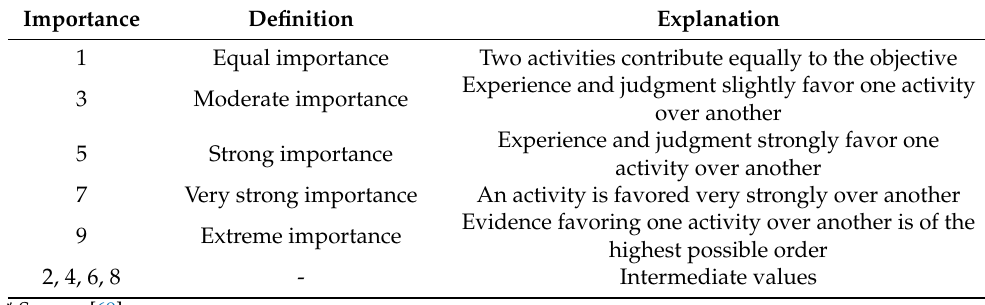
Table 4. The scale of comparison